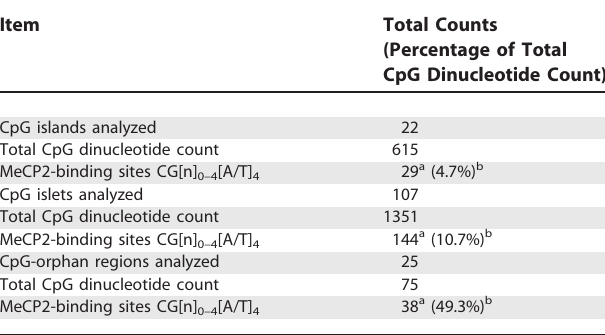
Table 2. Relative Distribution of Potential MeCP2-Binding Sites Flanking the CpG Islands, CpG Islets, and CpG Orphans Analyzed in This